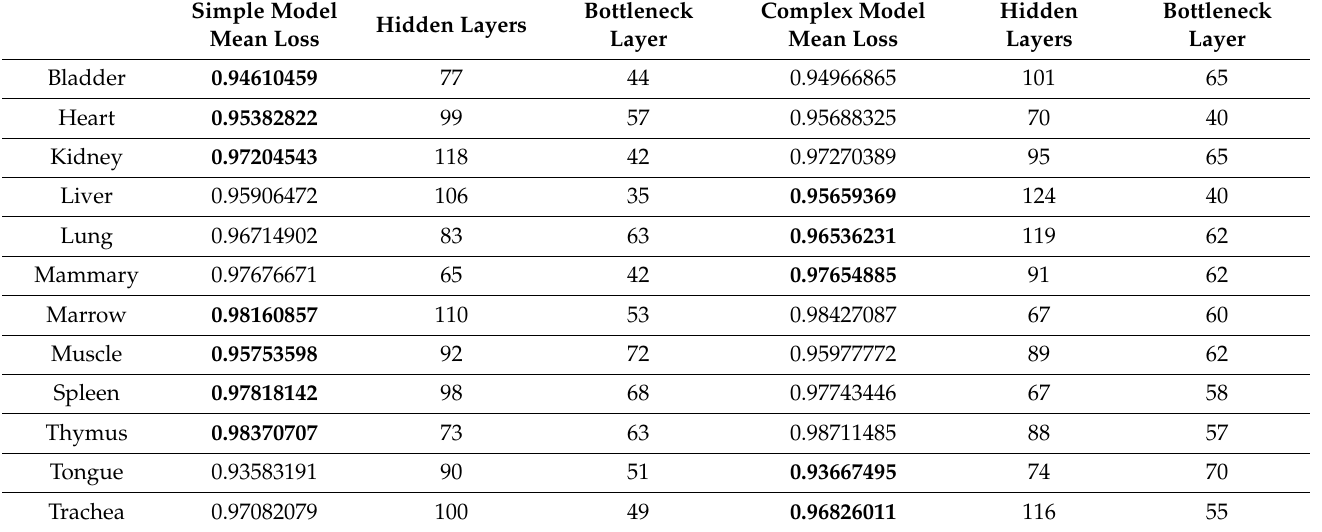
Table 2. Model test loss using a combined dataset with a simple and a more complex regularization. Bold indicates best